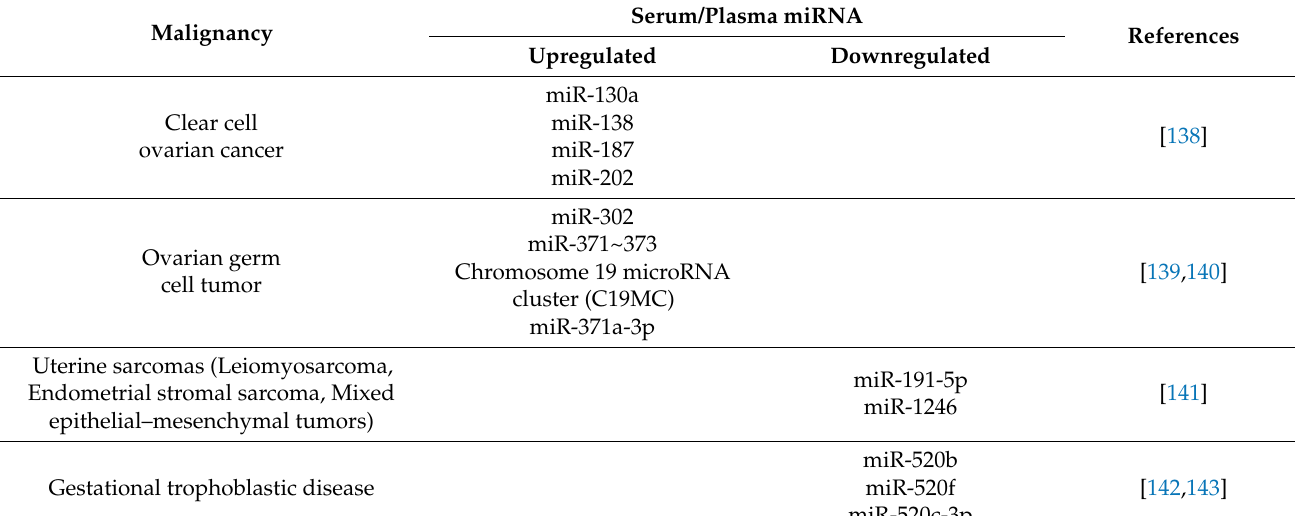
Table 2. miRNAs in serum/plasma of rare gynecological cancer